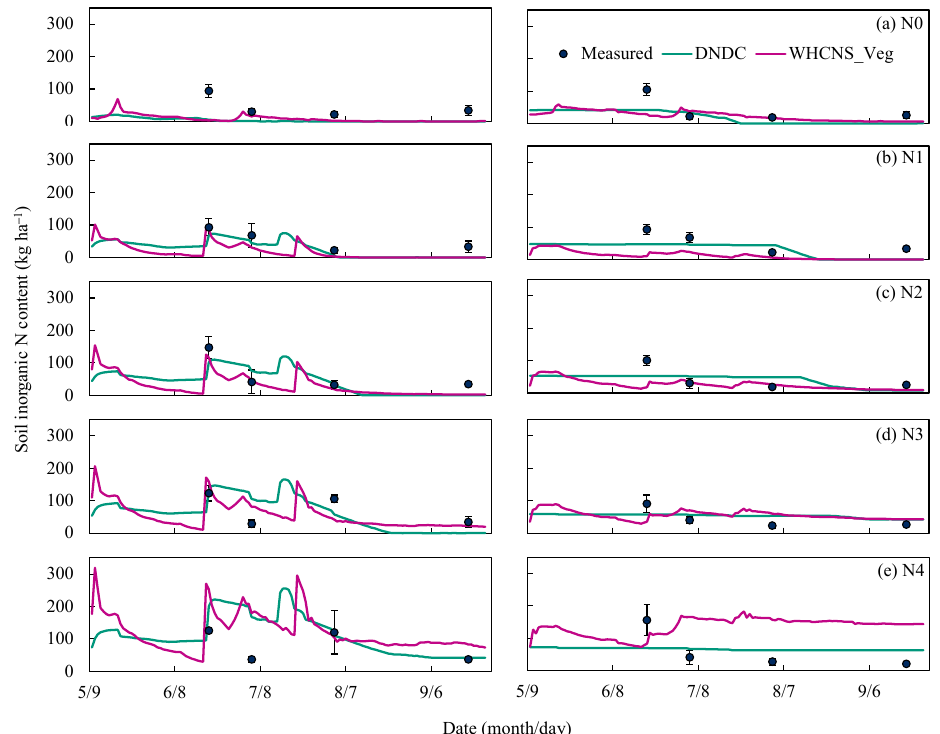
Figure 5. Daily simulated and measured soil inorganic N content at soil layer of 0–0.2 m (the left of the figure) and 0.2–0.4 m (the right of the figure) in Wuchuan, China. ( a ) N0 treatment; ( b ) N1 treatment ( c ) N2 treatment ( d ) N3 treatment ( e ) N4 treatment. Vertical bars represent standard deviations ( n =